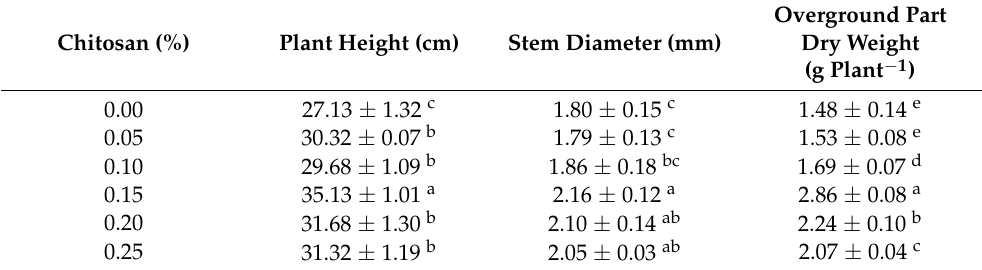
Table 4. Influences of chitosan soaking on height, stem diameter, and overground part dry weight of P. grandiflorus